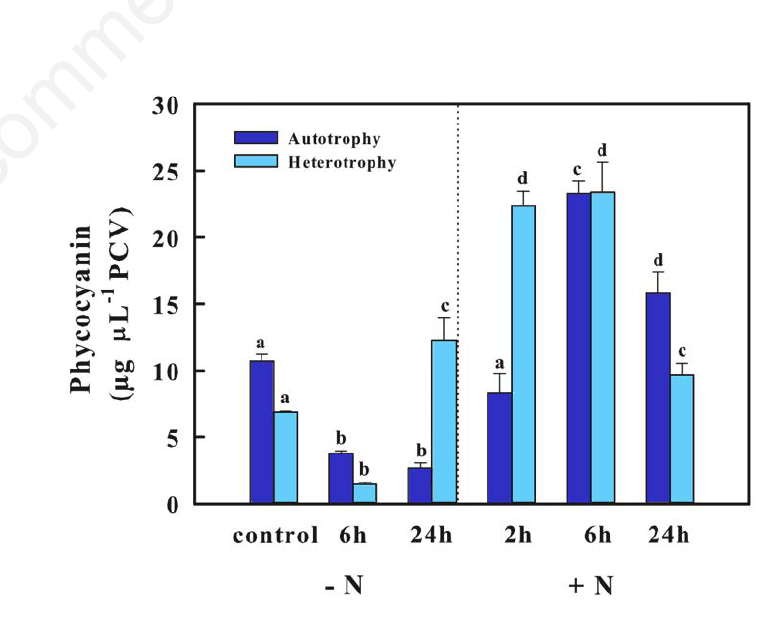
+ availability (N) in 4